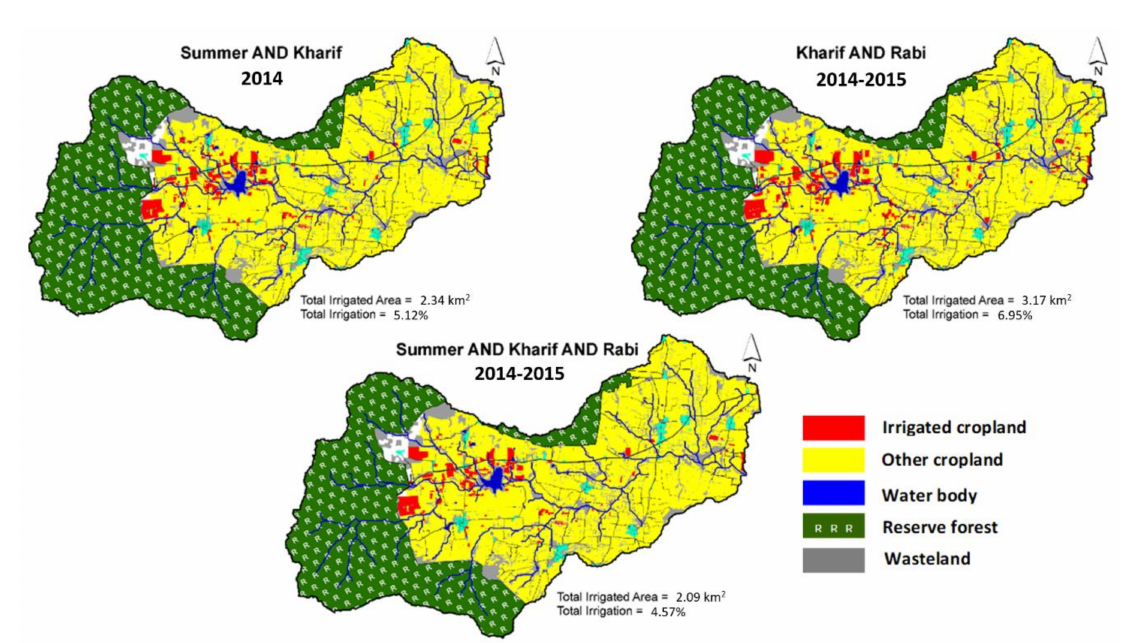
Figure 9. Classification of two-season (summer and kharif; kharif and rabi) and annually irrigated (summer and kharif and rabi) cropland for